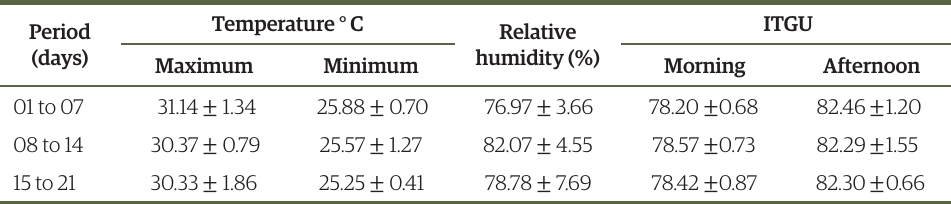
Table 2. Mean maximum and minimum temperature, relative air humidity and Index of Globe temperature and humidity (ITGU) inside the house during the experimental